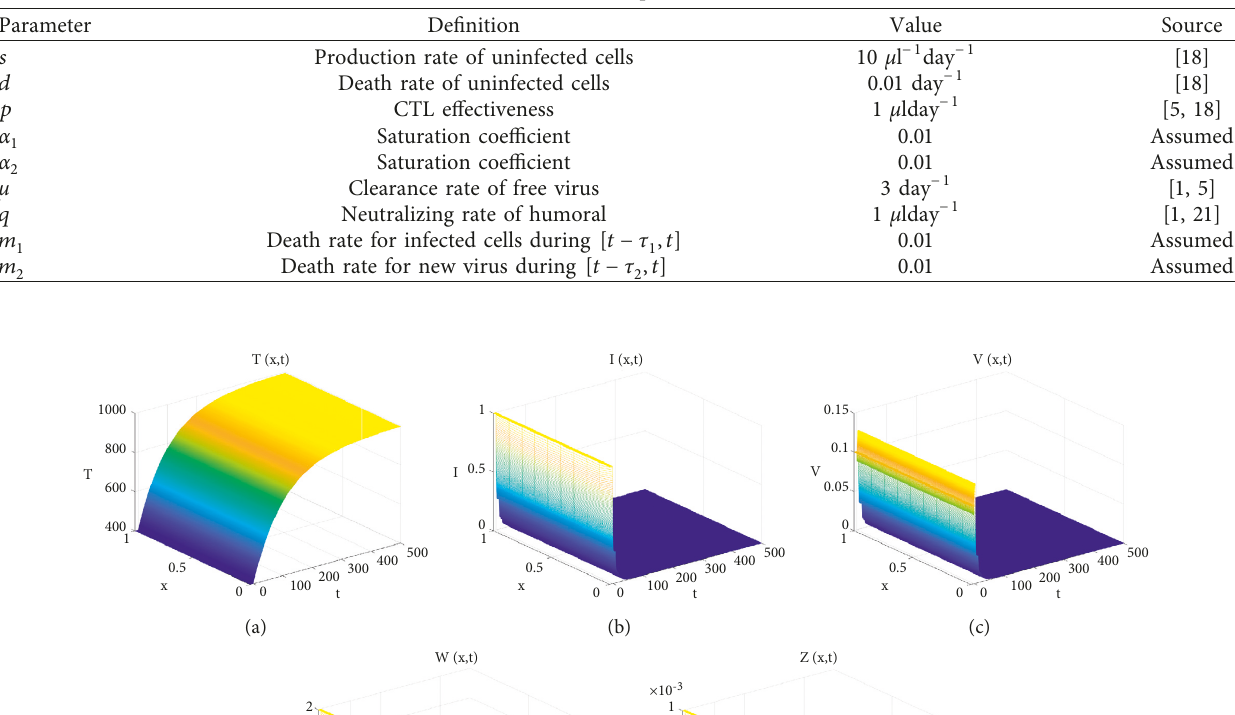
� 0 . 001, β � 0 . 001, c � 0 . 01, m � 0 . 001, δ � 0 . 5, h � 1 . 5, a � 1 . 5, k � 0 . 4, and b � 2, we have R 1 2